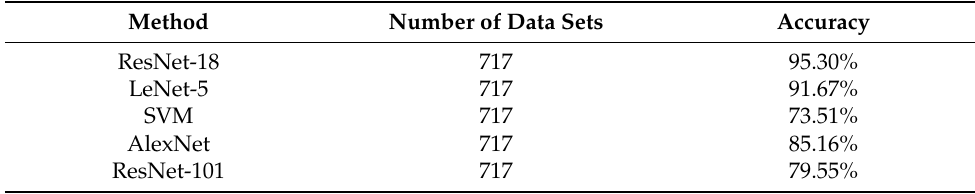
Table 2. Comparison of the accuracy of ResNet-18 and other